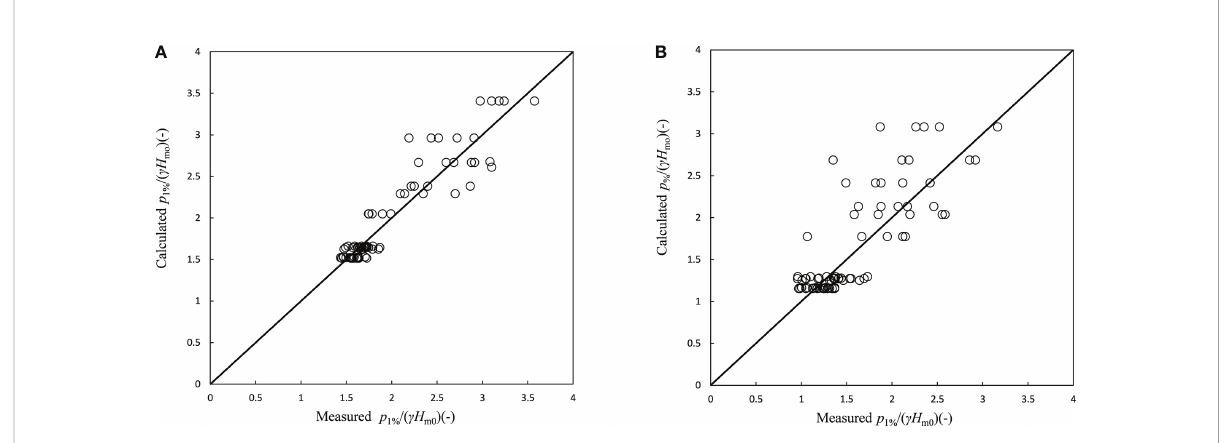
FIGURE 13 Comparison of measured and calculated maximum normal stress: (A) on the dike crest; (B) on the upper part of landward